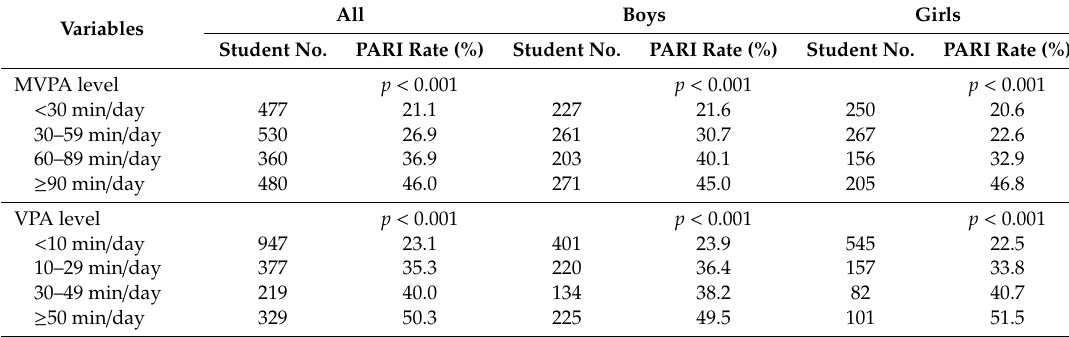
Table 3. Distribution of physical activity (PA) level and PARI occurrences among participants by sex.